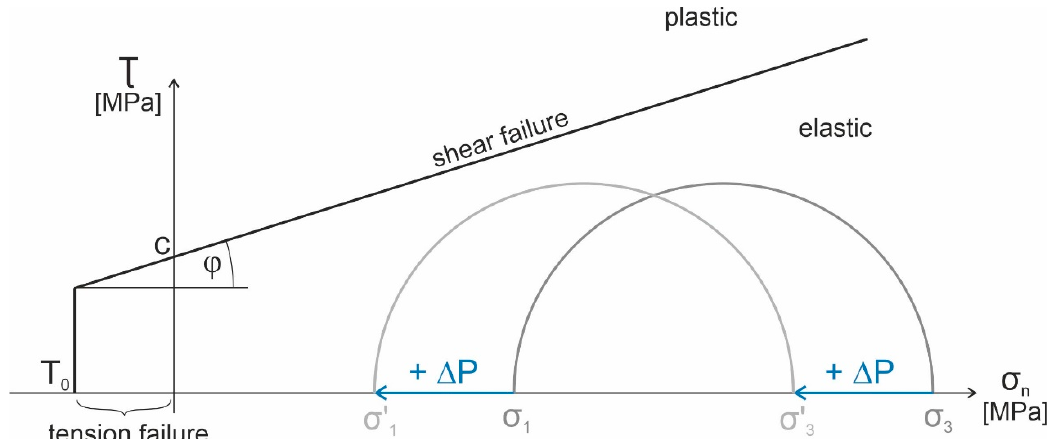
Figure 4. Shear stress τ vs. normal stress σ n diagram showing the Mohr–Coulomb failure criterion with a tension cut-off delimiting the elastic domain. An increase in pore pressure leads to a decrease in the effective stresses. Thus, the corresponding Mohr circle is shifted to the left towards the shear failure line. If the failure line is ultimately touched, plastic straining and—in case of a fault zone—fault reactivation occurs.